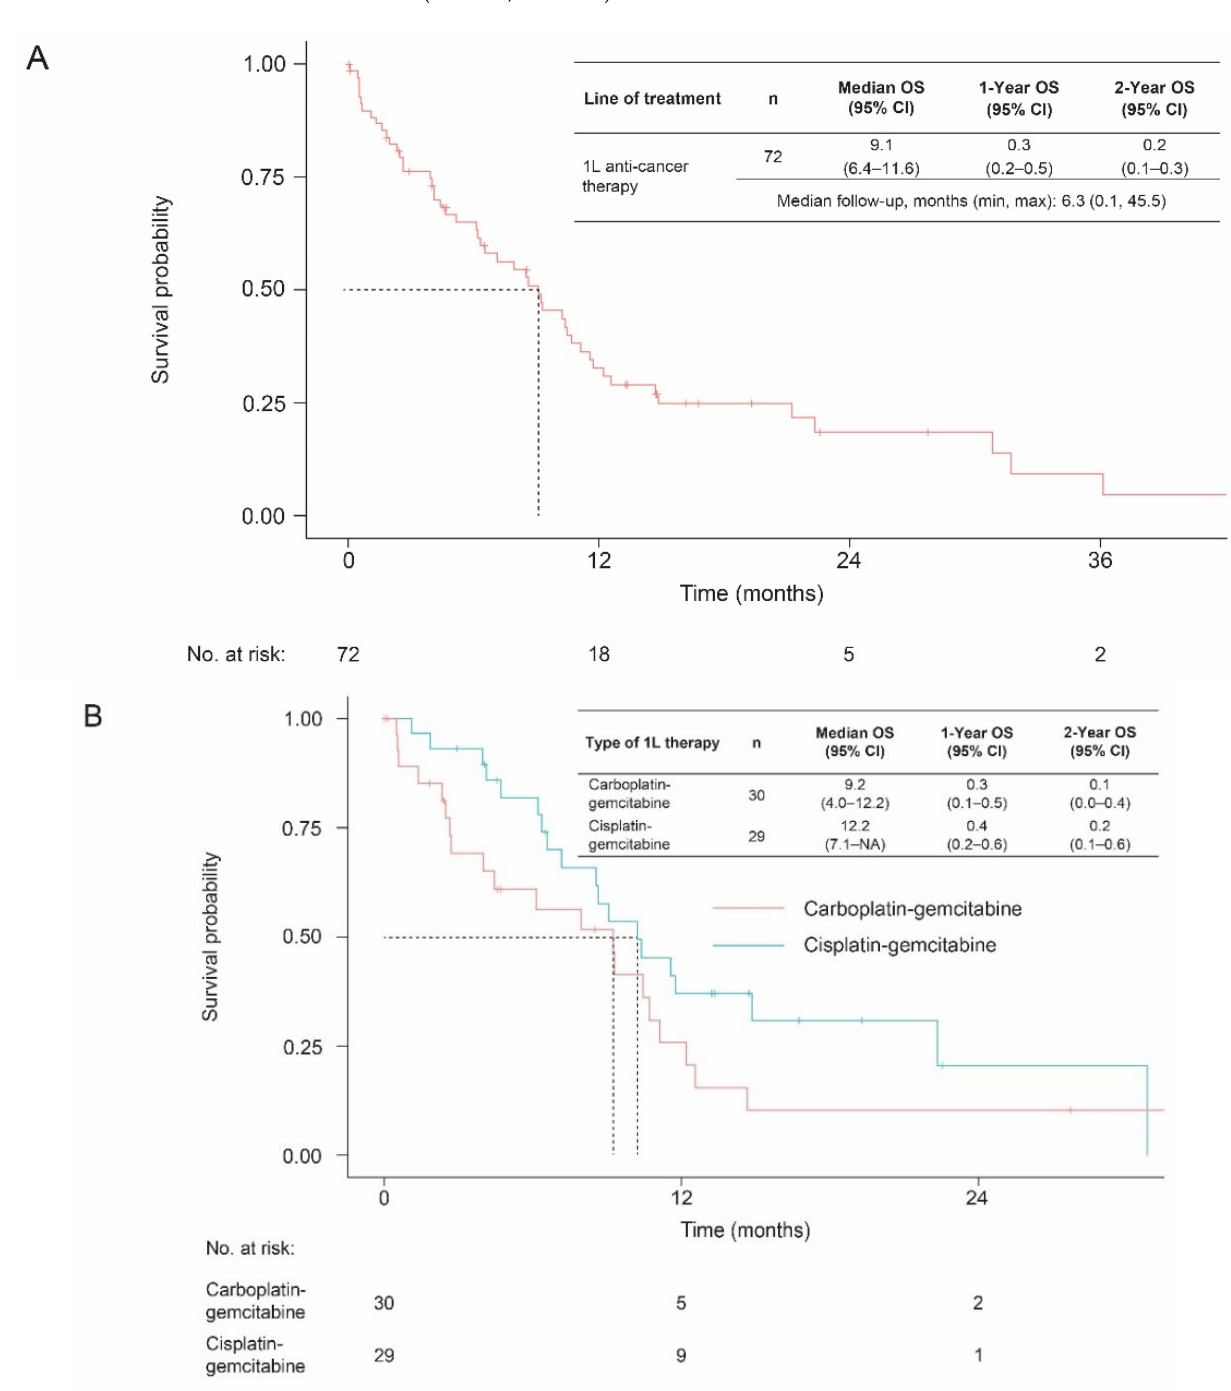
Figure 1. OS among patients with de novo la/mUC following initiation of 1L systemic therapy,